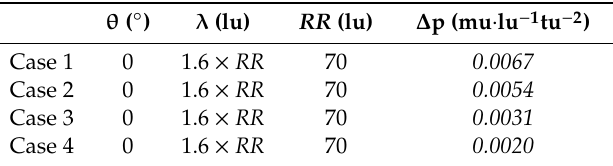
Table 1. Used parameters in Cases